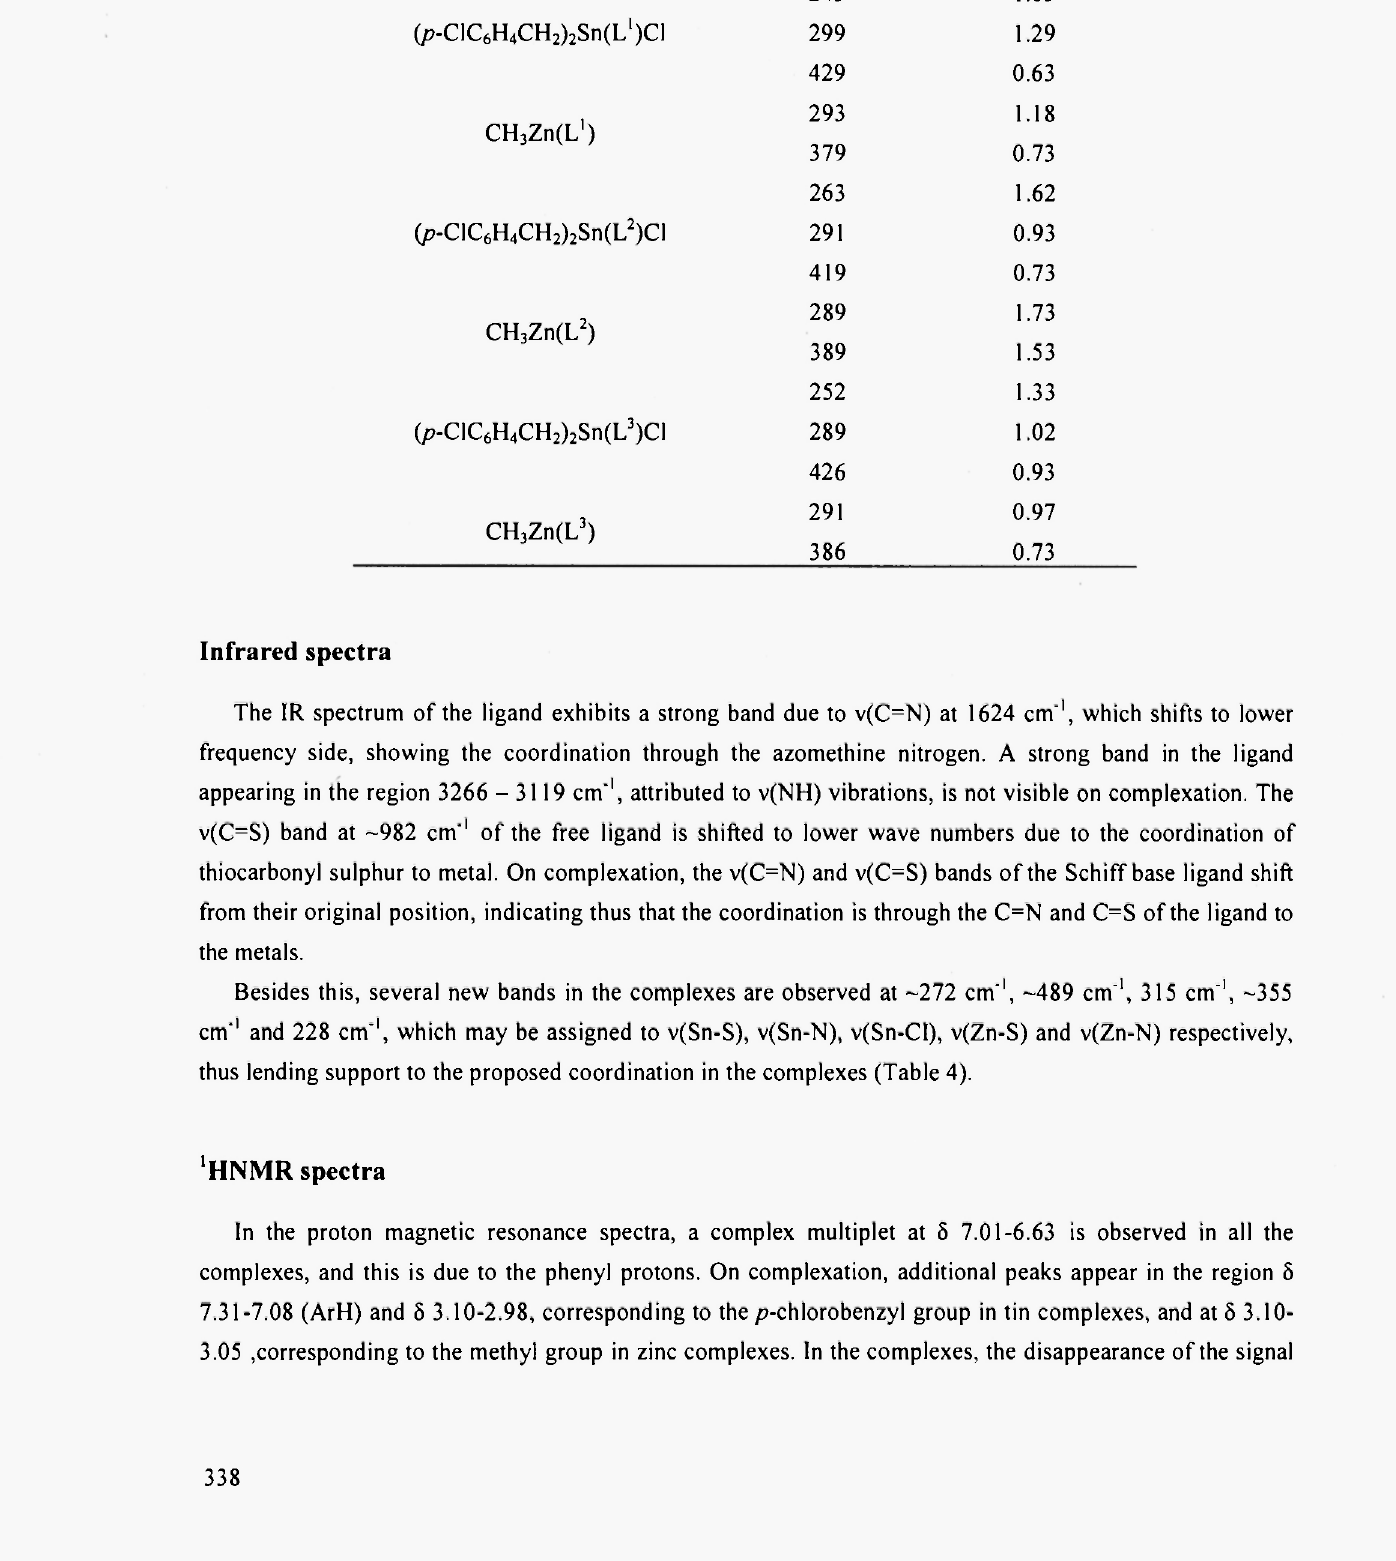
Table 3. Electronic data for the